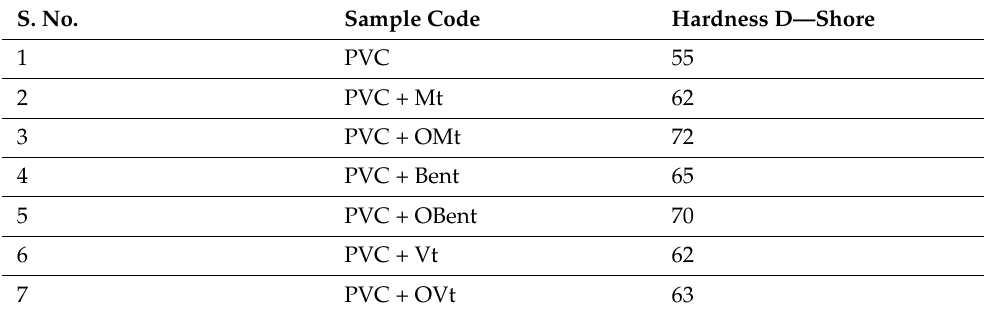
Table 4. Hardness of PVC polymer films and clay PVC polymer composite films. S.